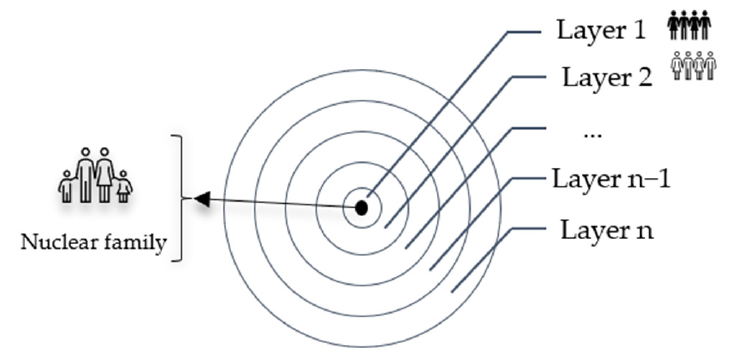
Figure 4. Multi-layer family model for a nuclear family.